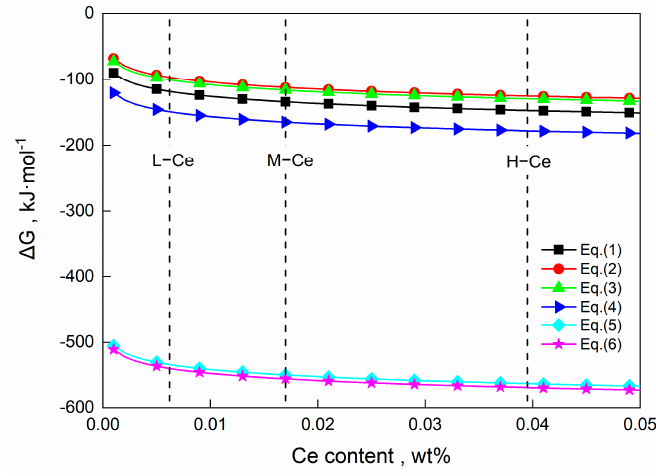
Figure 11. Relationship between Gibbs free energy of Ce modification reaction in molten steel and Ce content at 1600 °C.